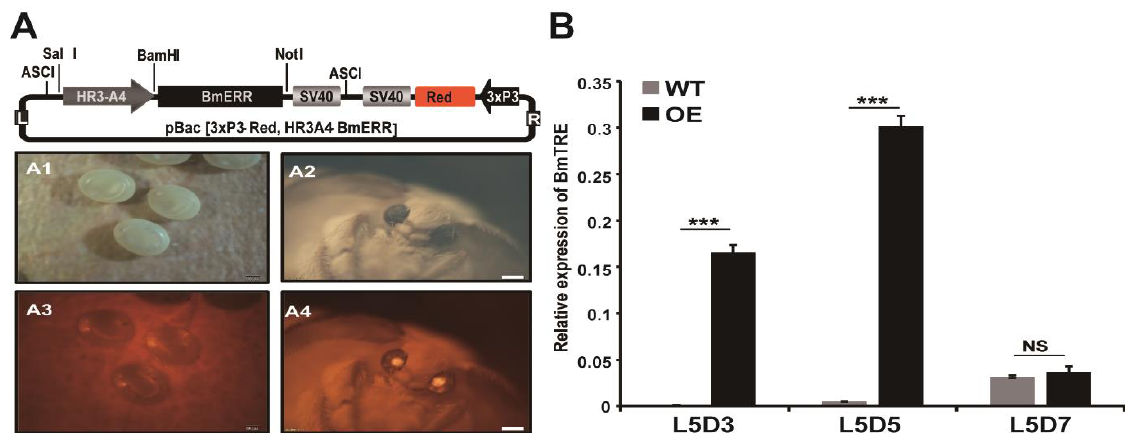
Figure 5. Transgenic overexpression of BmERR. ( A ) Schematic diagram of the BmERR transgenic overexpression vector; pBacR and pBacL are the right and left arms of the transposon, respectively; 3xp3 EGFP simian vacuolating virus 40 is the transgene marker; Hr3 A4 is the promoter. A1 – 4 Screening of positive transgenic Bombyx mori under a fluorescence microscope; (A1/2) white light image of transgenic B. mori eggs/moth; (A3/4) fluorescence image of transgenic B. mori eggs/moth ( B ) The expression of BmTreh in the midgut of BmERR transgenic lines. *** p < 0.001, NS: No significant differ- ence.